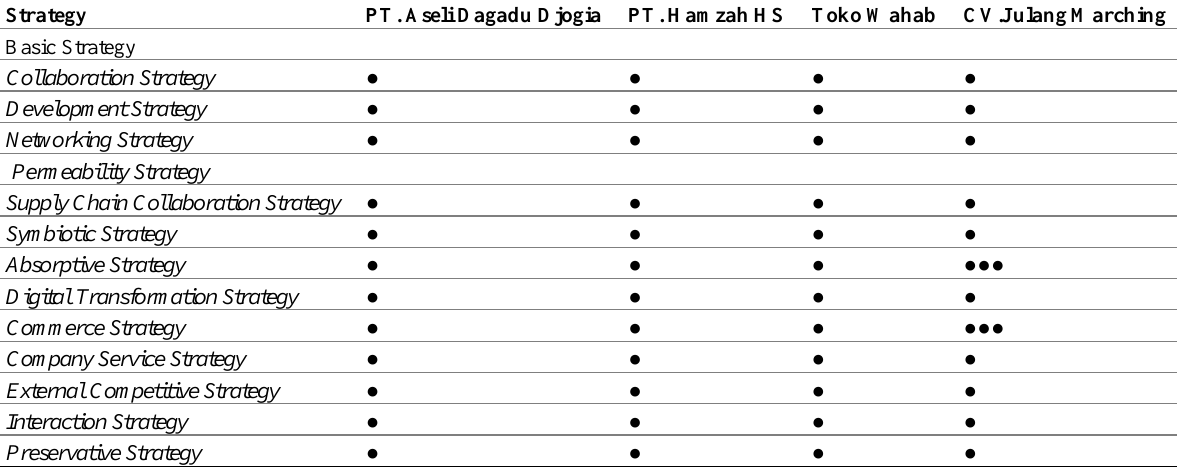
Table 1: Company